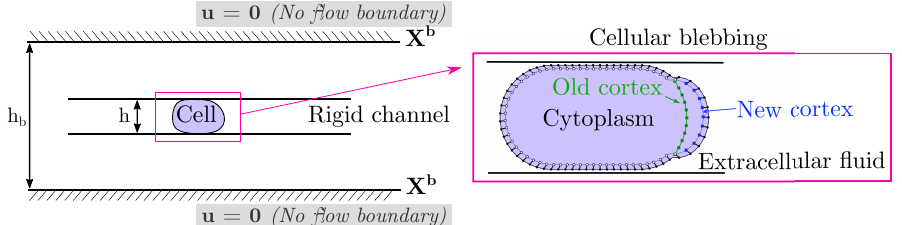
Figure 1. Schematic of blebbing cell in a channel. In our model, a cell is compressed within a rigid channel of adjustable wall geometry and height. No flow boundary conditions are enforced at an outer boundary X b . The default setup is a confinement height of h = 13 µ m for a 20 µ m diameter cell with an outer boundary of height h b = 32 µ m. The cell model consists of an incompressible plasma membrane (black dots), a (visco)elastic actomyosin cortex (white, green, and blue square points), and a viscous cytoplasm. The lines connecting membrane and cortex points represent membrane-cortex attachment